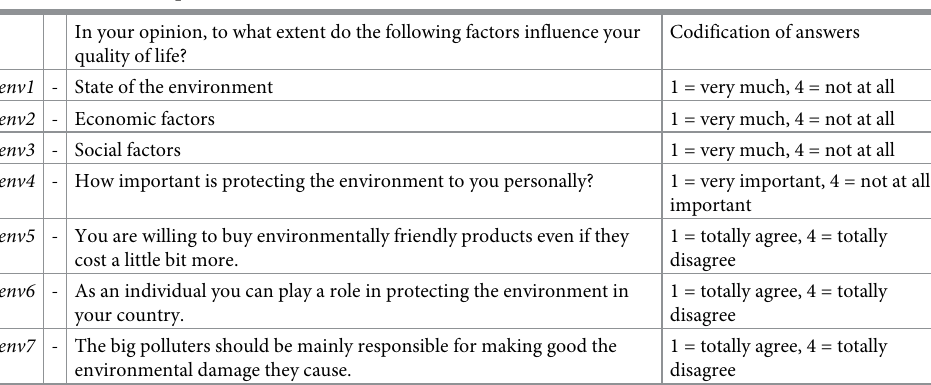
Table 2. Attitudinal